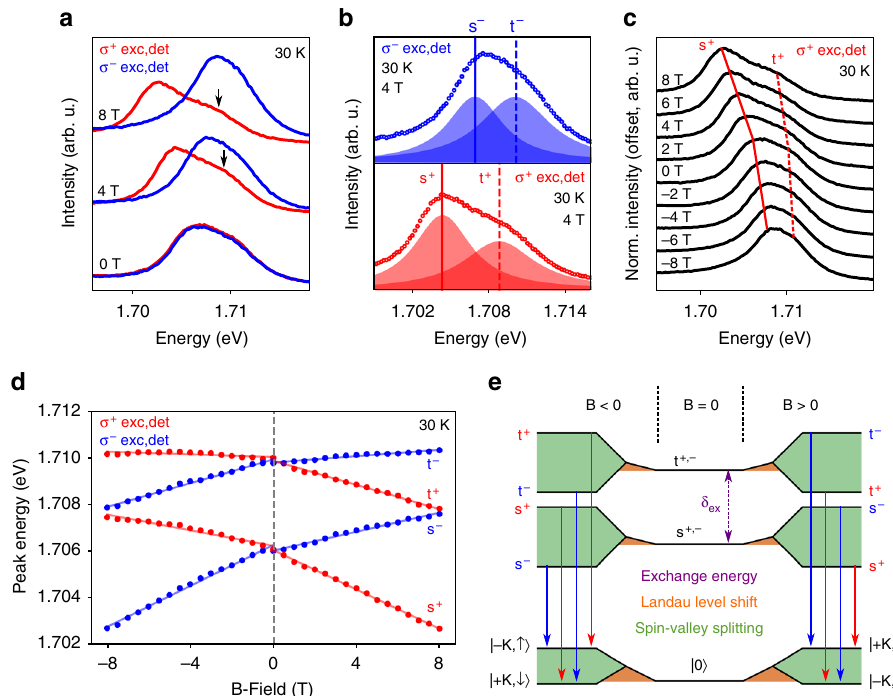
Fig. 3 Photoluminescence of singlet and triplet trions under external magnetic fi elds. a Circular polarization resolved trion PL spectra at B = 0 T, 4 T, and 8 T, at 30 K. Oppositely polarized PL components shift spectrally away from each other with increasing B- fi eld. The energy separation between trion fi ne structure components appears dependent on B - fi eld, as evidenced by the growing separation between the main peak and the shoulder (indicated by black arrows) in σ + polarization (red curve) with increasing fi eld strength. The increasing symmetry and intensity of the emission in σ − polarization (blue curve) suggests converging fi ne structure components with B . b The trion fi ne structure may be fi tted to two Lorentzian peaks in each photon helicity, showing all four trion con fi gurations at B = 4 T. Open circles are the CCD data. c B- fi eld dependent trion PL in σ + polarization. Solid and dashed red lines trace the approximate peak energies of the fi tted Lorentzian functions for s + and t + , respectively, shown in b . d Fitted peak energies of the fi ne structure components as a function of external B - fi eld strength. Solid lines are linear fi ts to the data for either positive or negative fi eld ranges. e Energy level diagram showing initial (one of the four trion varieties) and fi nal (photon plus single electron in band c1) states of trion optical recombination, at positive and negative B - fi elds. The intervalley electron-hole exchange interaction creates the energy gap δ ≠ 0, ex , lifting the degeneracy between singlet and triplet trions. When B energy shifts arise from Landau level quantization of both trions and free electrons (orange areas), along with spin and valley associated magnetic moments (green areas). See main text for details. Energies are not to